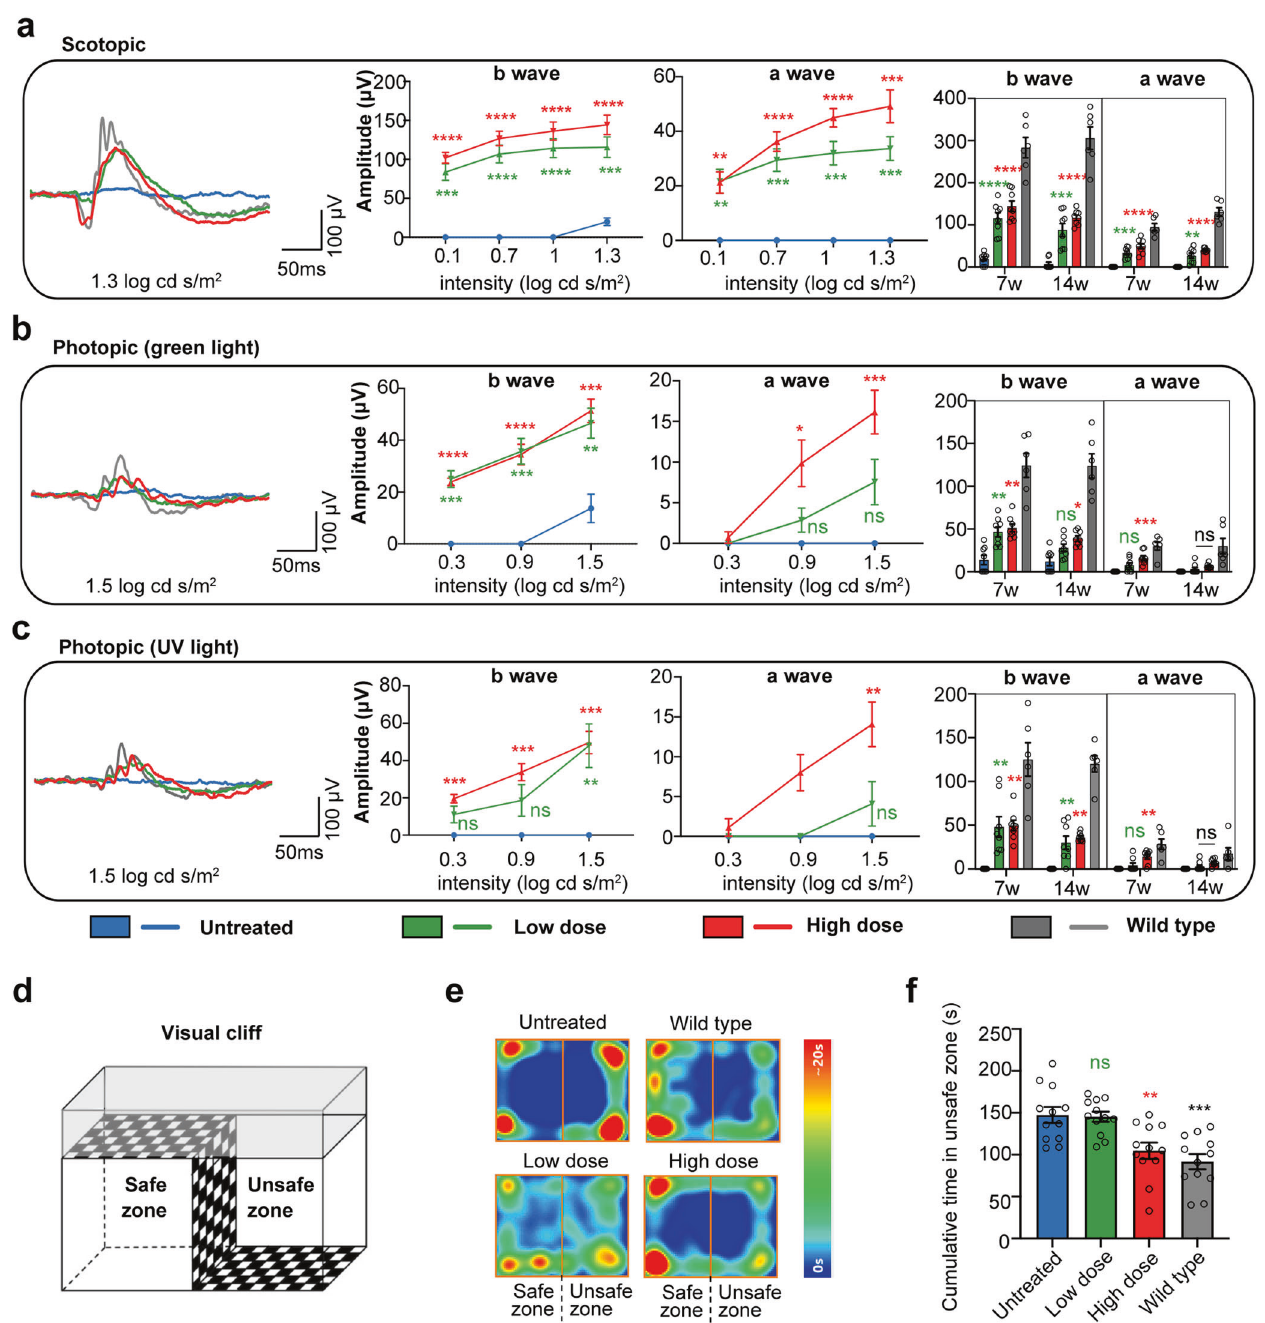
Fig. 5 Restoration of retinal and visual function in rd12 mice after prime editing. Representative ERG waveforms (left), b- and a-wave amplitudes at 5 weeks post injection (7 weeks of age) (middle two), and the comparison of the b- and a-wave amplitudes between 5 weeks and 12 weeks post injection (right) under scotopic ( a ), green light photopic ( b ) and UV light photopic ( c ) conditions. The representative ERG waveforms on the left are recorded under the stimulation at a light stimulus of 1.3 log cd s/m 2 in scotopic conditions and 1.5 log cd s/m 2 in photopic conditions. The b- and a-wave amplitude comparisons on the right are under the same conditions. Two-way ANOVA and post hoc Dunnett ’ s for the comparison to untreated group in middle graphs, and own-way ANOVA and post hoc Dunnett ’ s for the comparison to untreated group in right graphs. * P < 0.05, ** p < 0.01, *** P < 0.0001, **** P < 0.00001, ns nonsigni fi cant difference. d Visual cliff test assembly composed of a safe zone and an unsafe zone. The cumulative time the mice spent in the safe and unsafe zones was recorded. e The representative heatmap representing time spent at each position related to the place preference of WT, untreated and treated mice at 5 weeks post injection. f The cumulative time spent in the unsafe zone at 5 weeks post injection of WT, untreated and treated mice. Data are shown as mean ± SEM, n = 12 for each group. One-way ANOVA and post hoc Dunnett ’ s test were used for comparisons to the untreated group. ** p < 0.01, *** p < 0.001; ns nonsigni fi cant